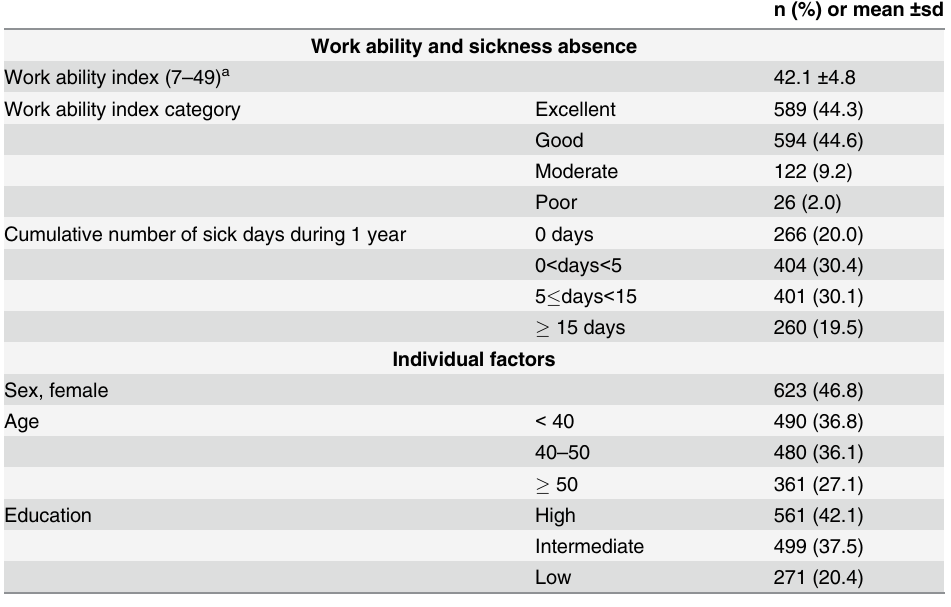
Table 1. Characteristics of study sample consisting of office workers (n =